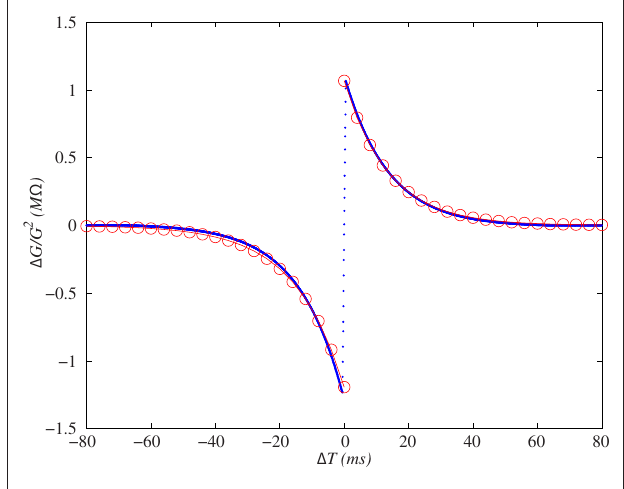
Figure 27 | Spectre characterization of STDP learning function of memristors. Blue dots are results obtained from Spectre electrical circuit simulations. Red circles correspond to the theoretical target function used in the theoretical behavioral